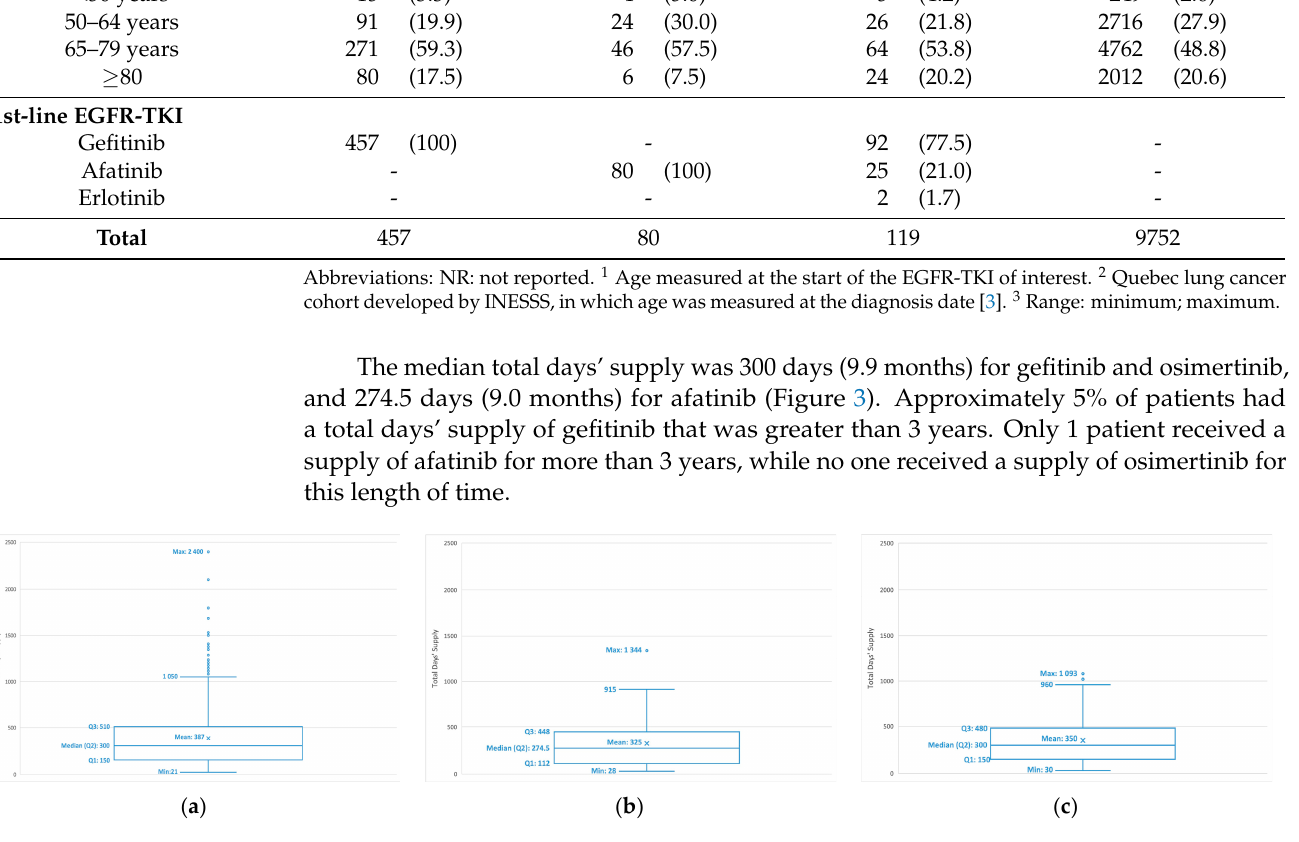
Figure 3. Distribution of total days’ supply: ( a ) 1st ‐ line gefitinib cohort (N = 457); ( b ) 1st ‐ line afatinib cohort (N = 80); ( c ) Post ‐ EGFR ‐ TKI osimertinib cohort (N = 119). Abbreviations: min: minimum; Q1: quartile 1; Q2: quartile 2 or median; Q3: quartile 3; max: maximum. The lower limit of the boxplot mustache represents the minimum, whereas the superior limit is equal to 1.5 times the interquartile range (Q3 minus Q1) plus Q3.